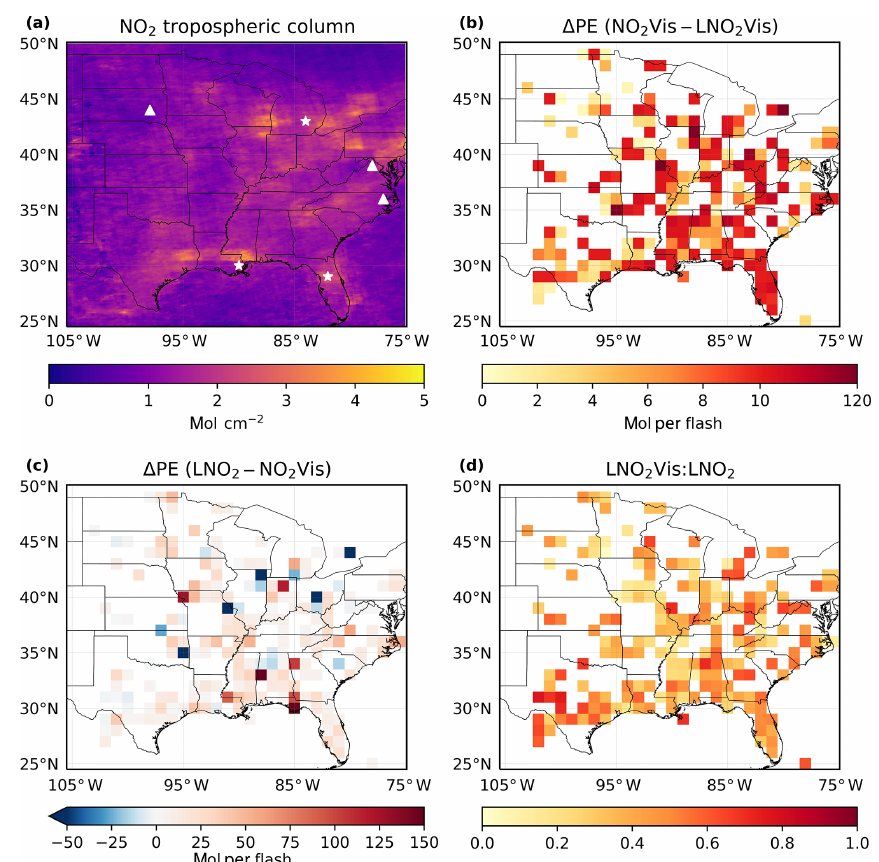
Figure 6. (a) Mean (MJJA 2014) NO 2 tropospheric column. Polluted cities are denoted by stars (Lansing, New Orleans, and Orlando) while clean cities are denoted by triangles (Huron, Charles Town, and Tarboro). (b) The differences of the estimated mean production efficiency between NO 2 Vis and LNO 2 Vis with CRF ≥ 90%. (c) The same differences as (b) but between LNO 2 and NO 2 Vis. (d) The ratio of LNO 2 Vis to LNO 2